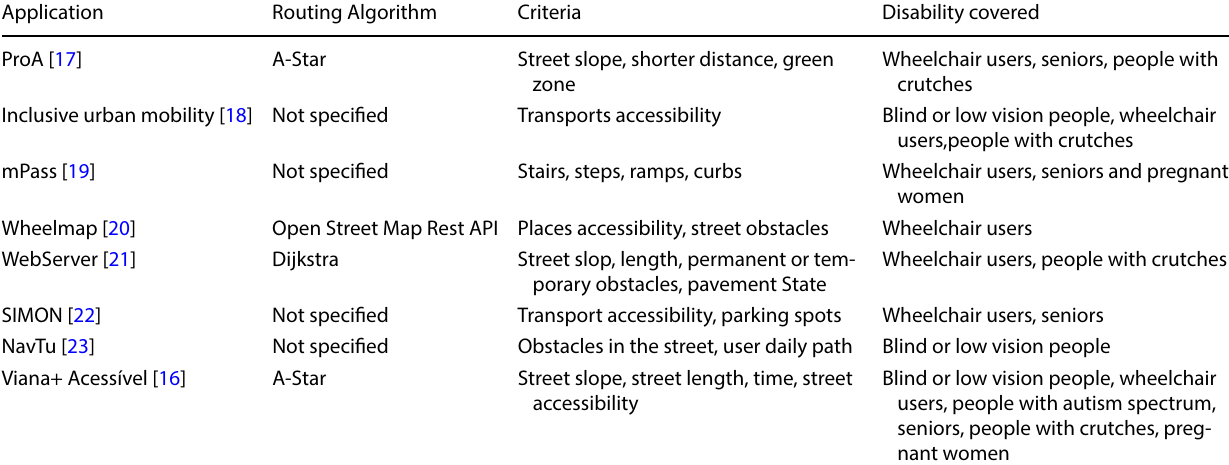
Table 1 Comparison of available mobile applications for users with mobility limitations